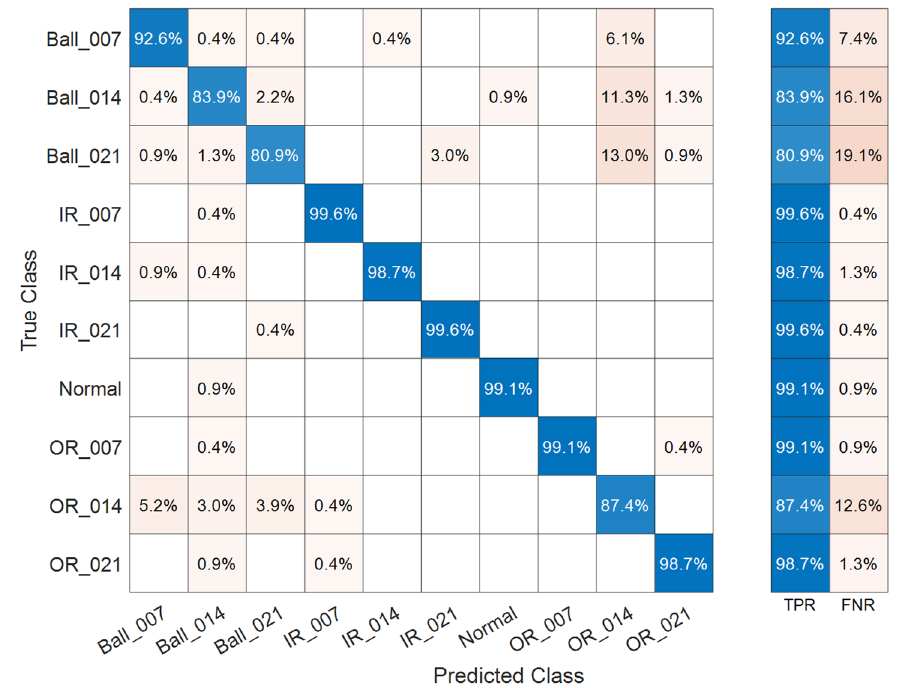
Figure 11. Confusion matrix of motor bearing failure prediction in coarse Gaussian SVM on the noisy environment, with a total accuracy of 88.3%.